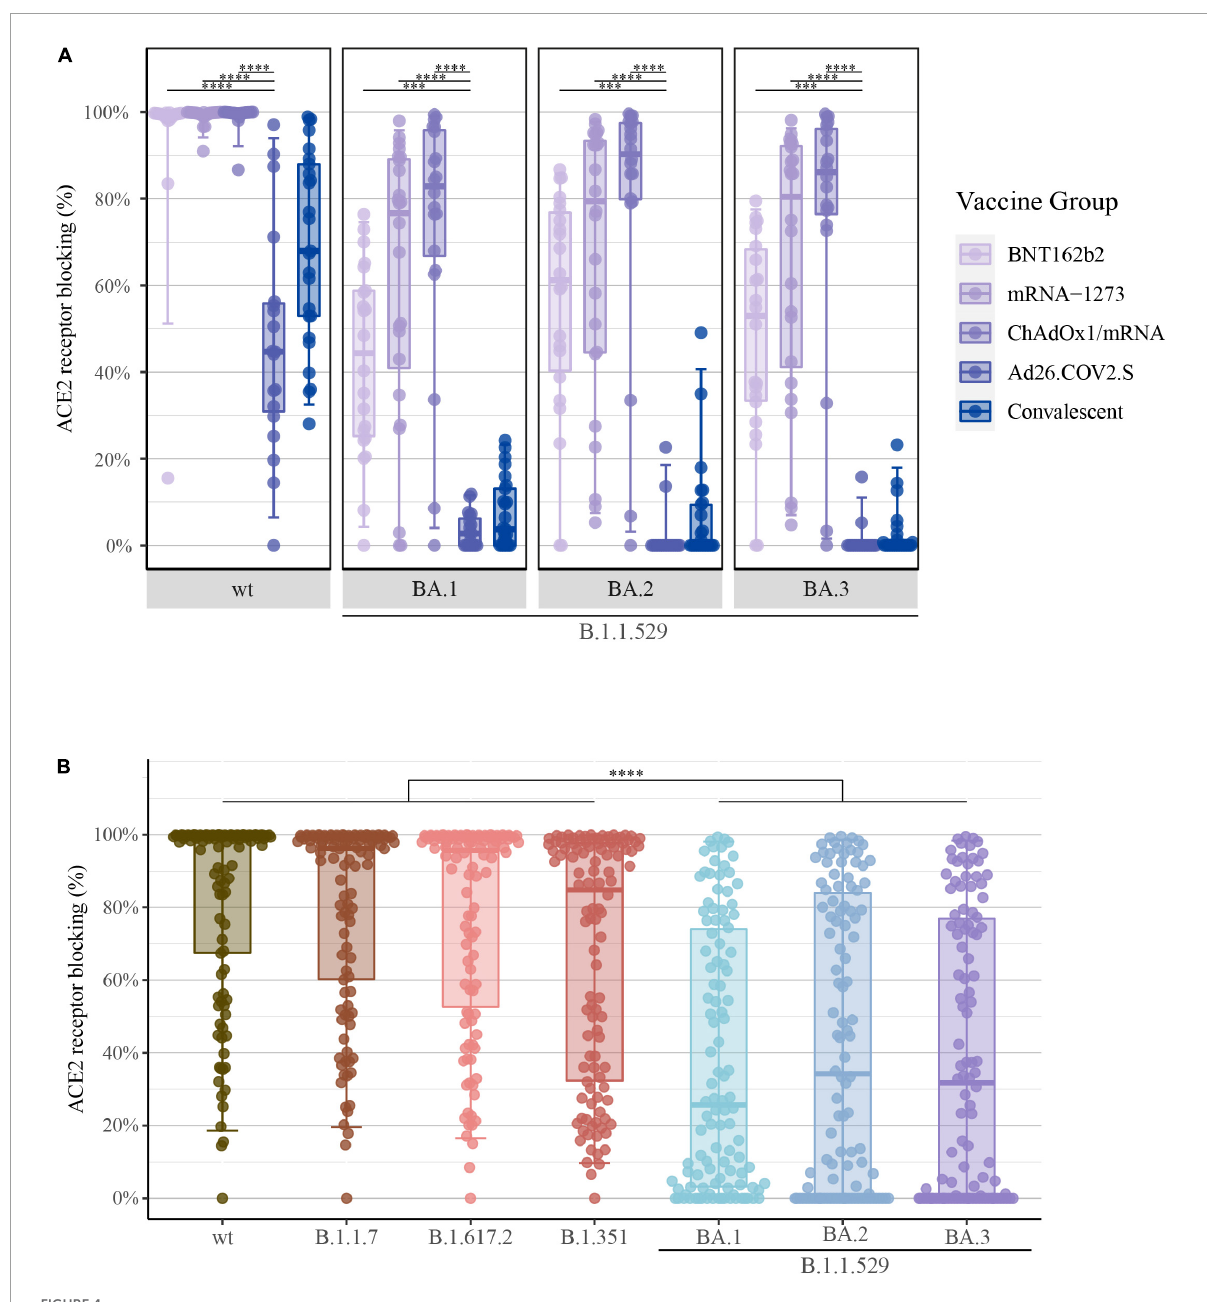
FIGURE4 Percentage of ACE2 receptor blocking after COVID-19 vaccination: (A) Percentage of ACE2 receptor blocking induced by primary COVID-19 vaccination with BNT162b2 ( n = 22), mRNA-1273 ( n = 24), ChAdOx1/mRNA ( n = 20) or Ad26.COV2.S ( n = 19) quantified by the MSD platform (serum 1:10). Data from convalescent comparators ( n = 25) are also displayed, but are not included in the statistical analysis. From left to right: SARS-CoV-2-S wt (Wuhan-Hu-1) and B.1.1.529; BA.1, BA.2 and BA.3 (Omicron). (B) Percentage of ACE2 receptor blocking merged for all vaccine types. From left to right: SARS-CoV-2-S wt, B.1.1.7 (Alpha), B.1.617.2 (Delta), B.1.351 (Beta), and B.1.1.529; BA.1, BA.2 and BA.3 (Omicron). All boxplots present the lower quartile, median and upper quartile, and the error bars indicate 95% CI. P -values were indicated as follows: *** p < 0.001 and **** p <